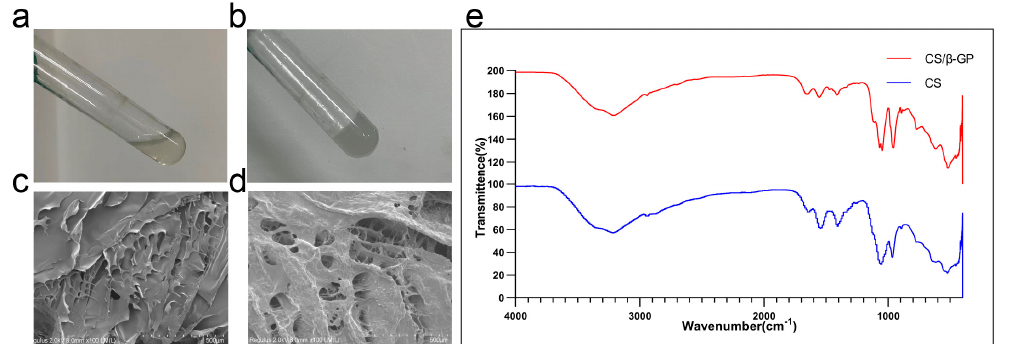
Figure 1. Hydrogel synthesis and characterization. ( a ) The solidification state of CS/ β –GP hydrogel. ( b ) Chitosan solution. ( c ) Scanning electron microscopy (SEM) image of chitosan solution. ( d ) Crosslinked CS/ β –GP SEM image. ( e ) FTIR spectrum of uncrosslinked CS solution and crosslinked CS/ β –GP hydrogel. Scale bars: c, d = 500 μ m.